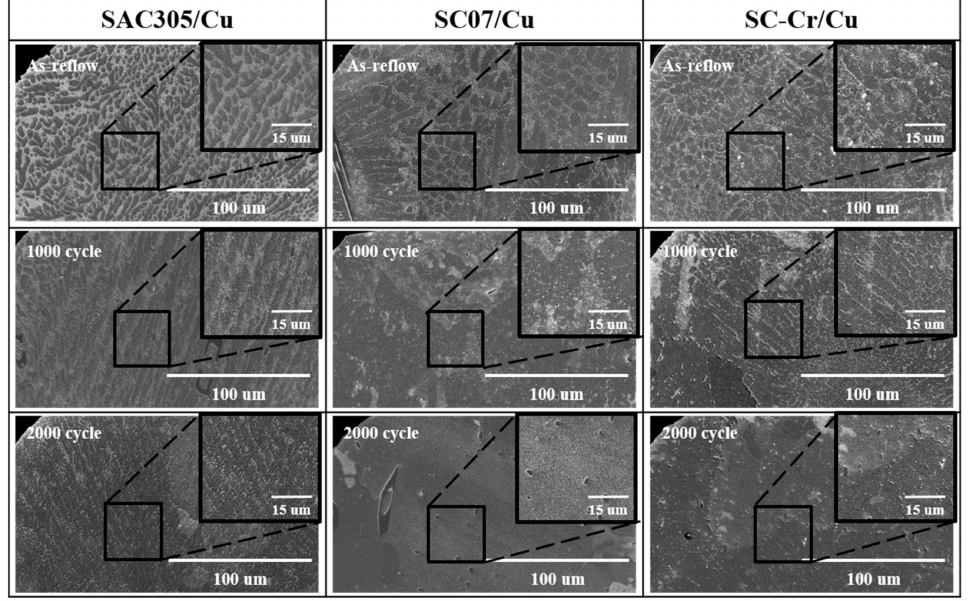
Figure 9. Microstructures of solder ball under various thermal shock cycles.